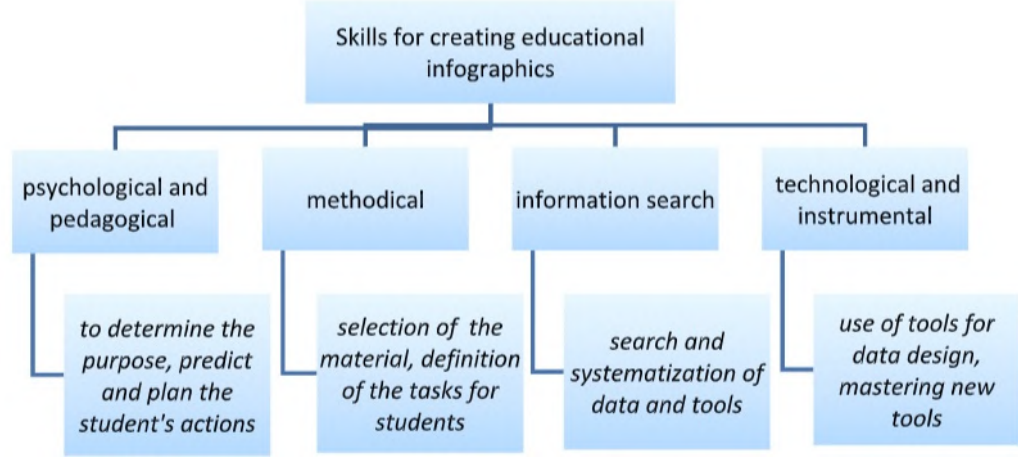
Figure 63: Presentation of paper [175].